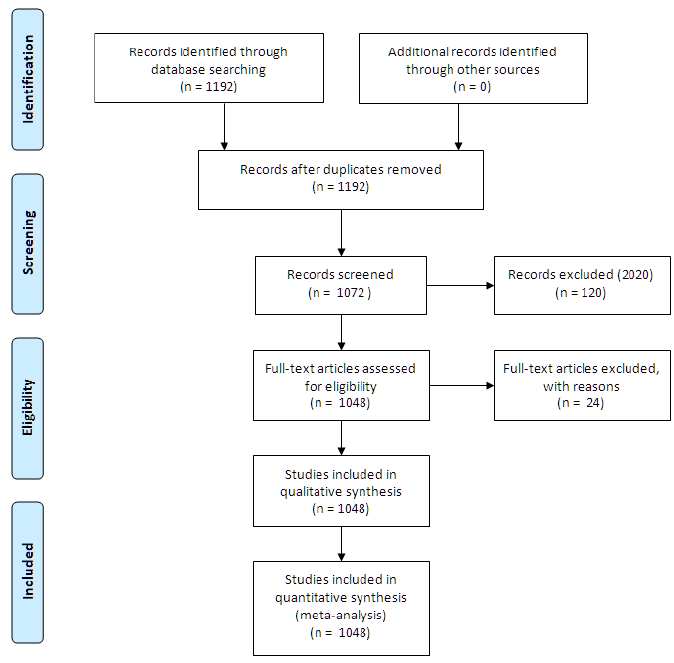
Figure 1. Flowchart according to the PRISMA declaration .